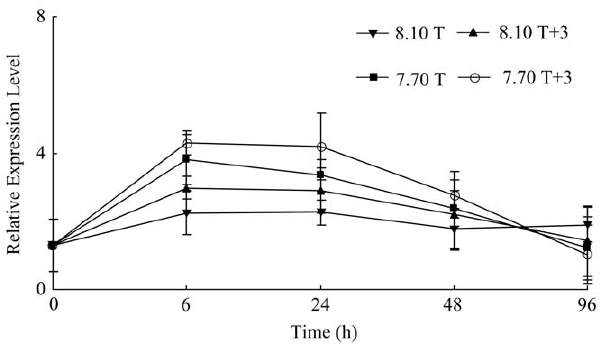
Figure 5. Real-time PCR analysis of expression of hsp70 in response to elevated temperature and declined pH.